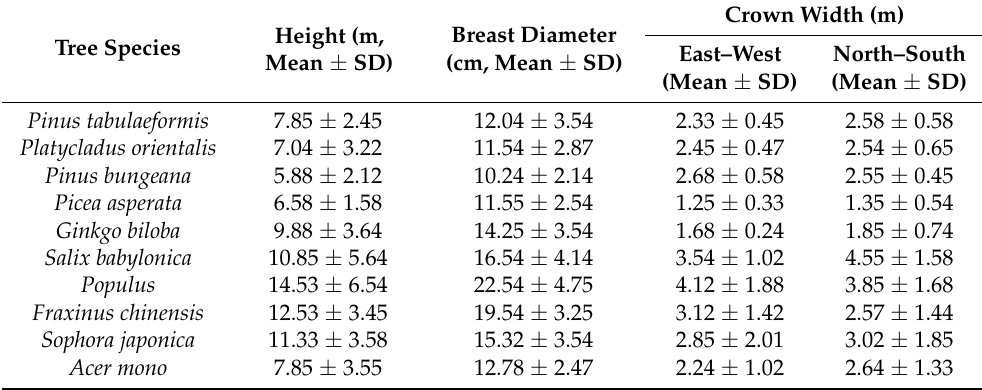
Table 1. Basic information on different tree